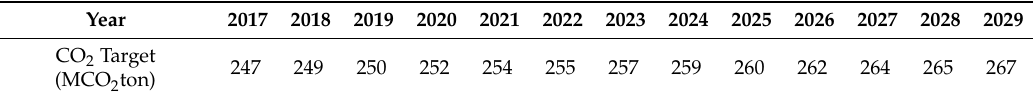
Table 6. Total CO 2 emissions